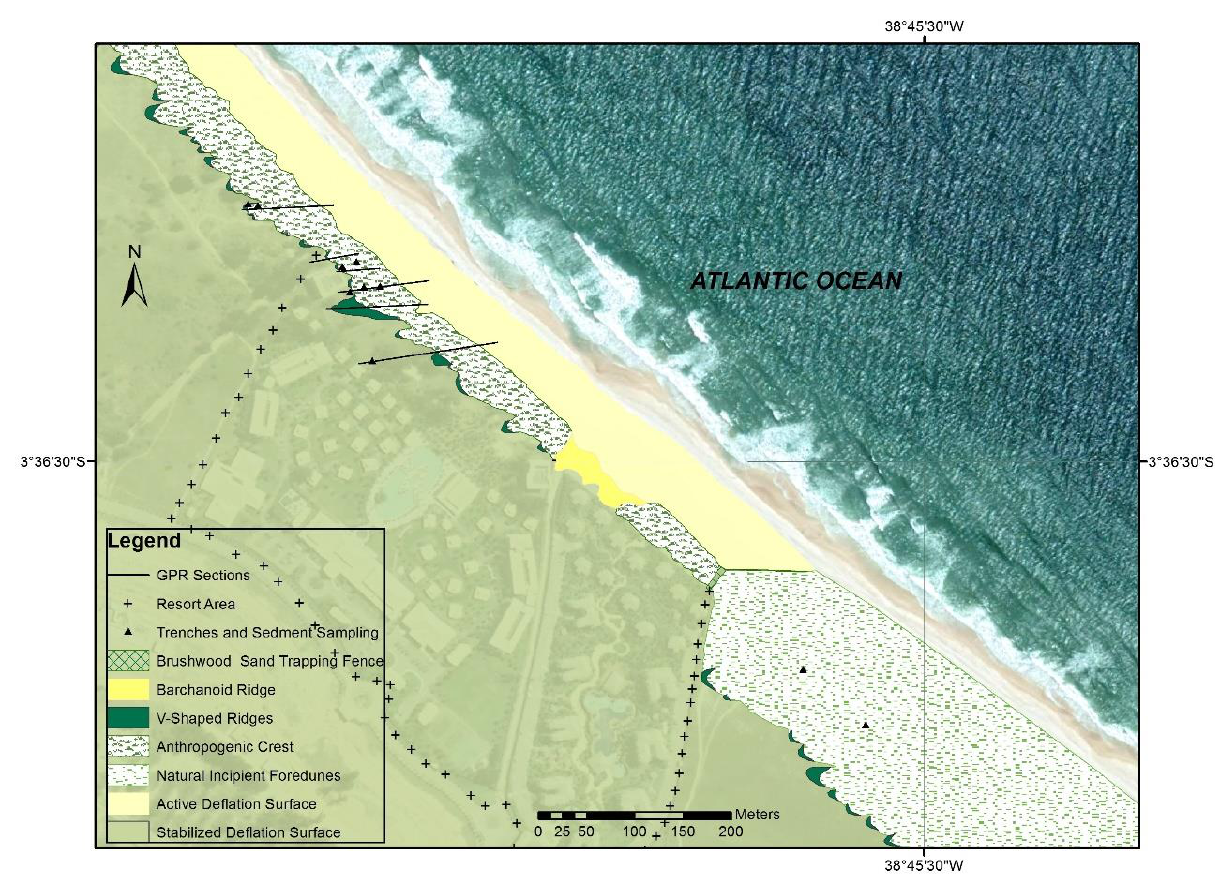
Figure 4. Morphological map showing the anthropogenic crest parallel to the beach, on which the vegetated stretches separated by preferential corridors of wind/incipient blowouts stand out. The active deflation surface to windward, and the stabilized deflation surface and the low V-shaped ridges the leeward. To the east, the incipient natural foredunes stand out.